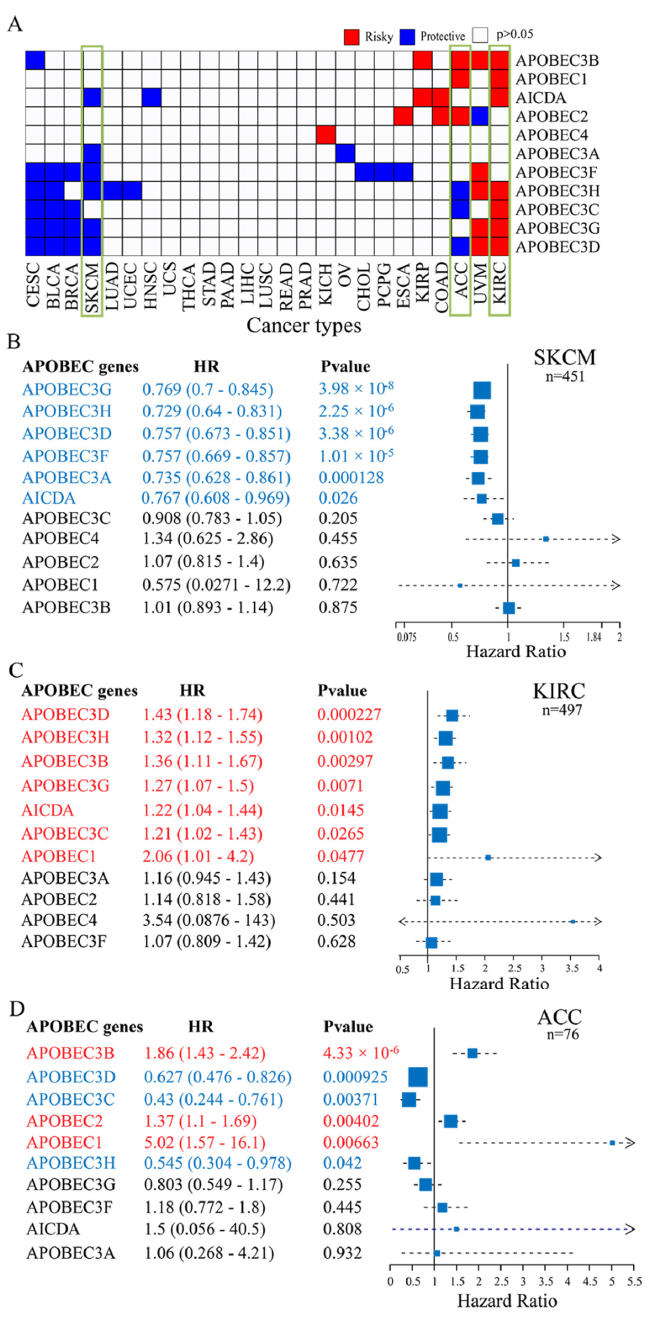
Figure 2. Prognostic value of APOBEC genes across cancer types. ( A ) Summary of the correlation between the expression of APOBEC genes and patient survival across cancer types. Red represents a higher expression of APOBEC gene associated with worse survival, and blue represents an association with better survival. Only p < 0.05 are shown; ( B – D ) Forest plots show the prognostic value (overall survival) for the 11 APOBEC genes in SKCM, KIRC, and ACC using a univariate Cox regression model, respectively. Hazard ratio > 1 represented risk factors for survival and hazard ratio < 1 represented protective factors for